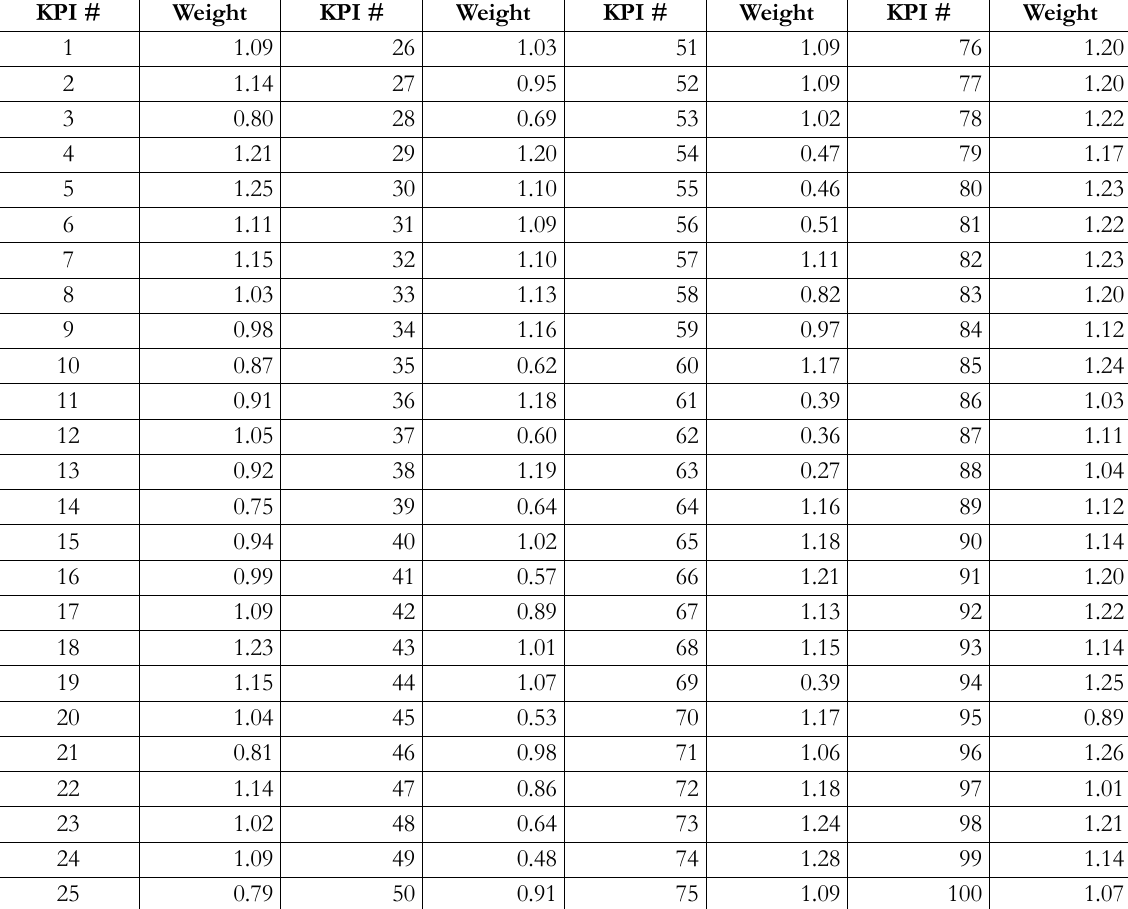
Table 2. Normalized weights for the 100 KPIs in the Technology Integration Model Weight Range (Normalized)